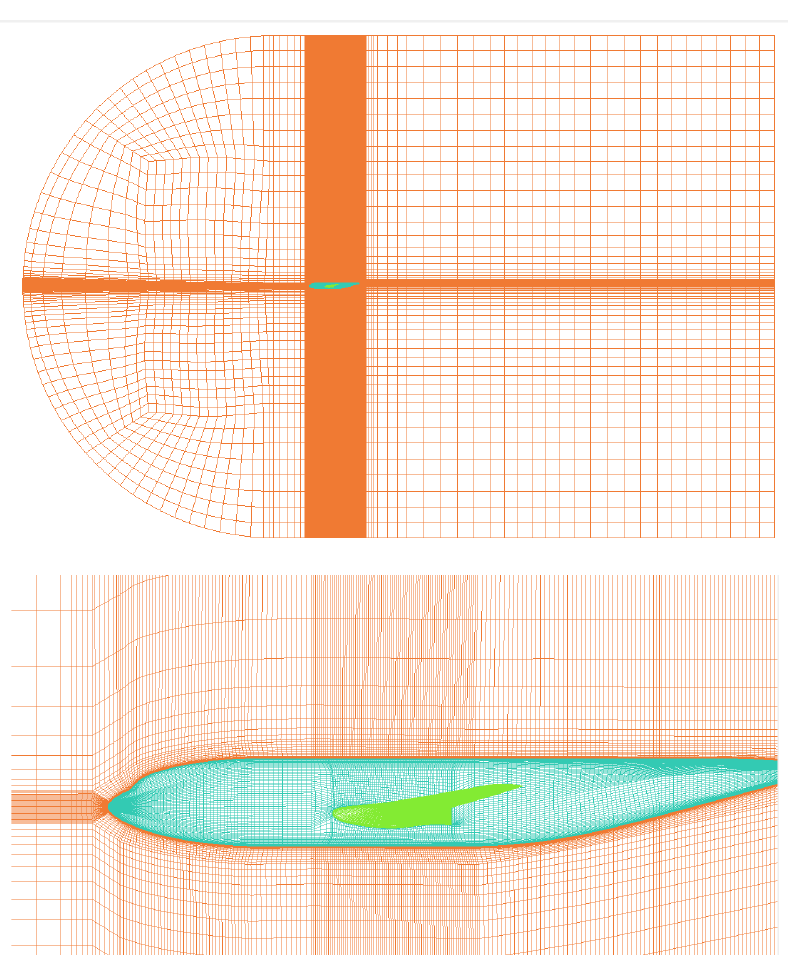
Figure 8. Multiblock structured mesh ( top left: block topology; top right: general view of mesh; middle: global view of mesh; bottom: body and wing).